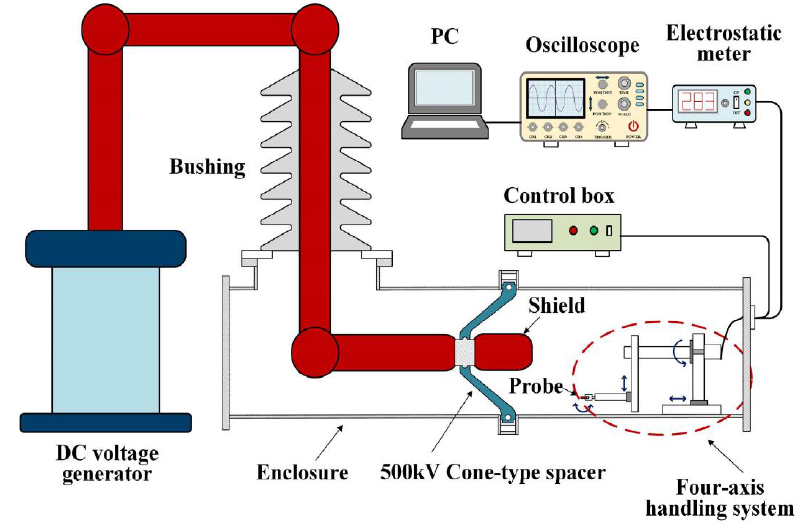
Figure 10. Schematic drawing of the experimental system setup [49].